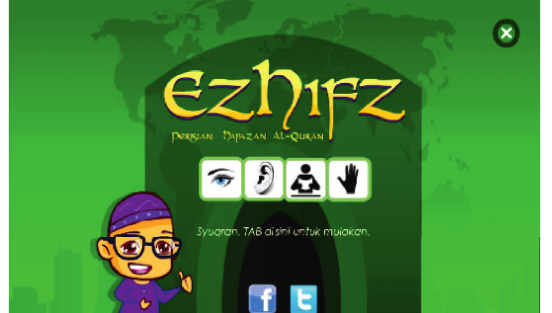
Figure 1: Home screen.